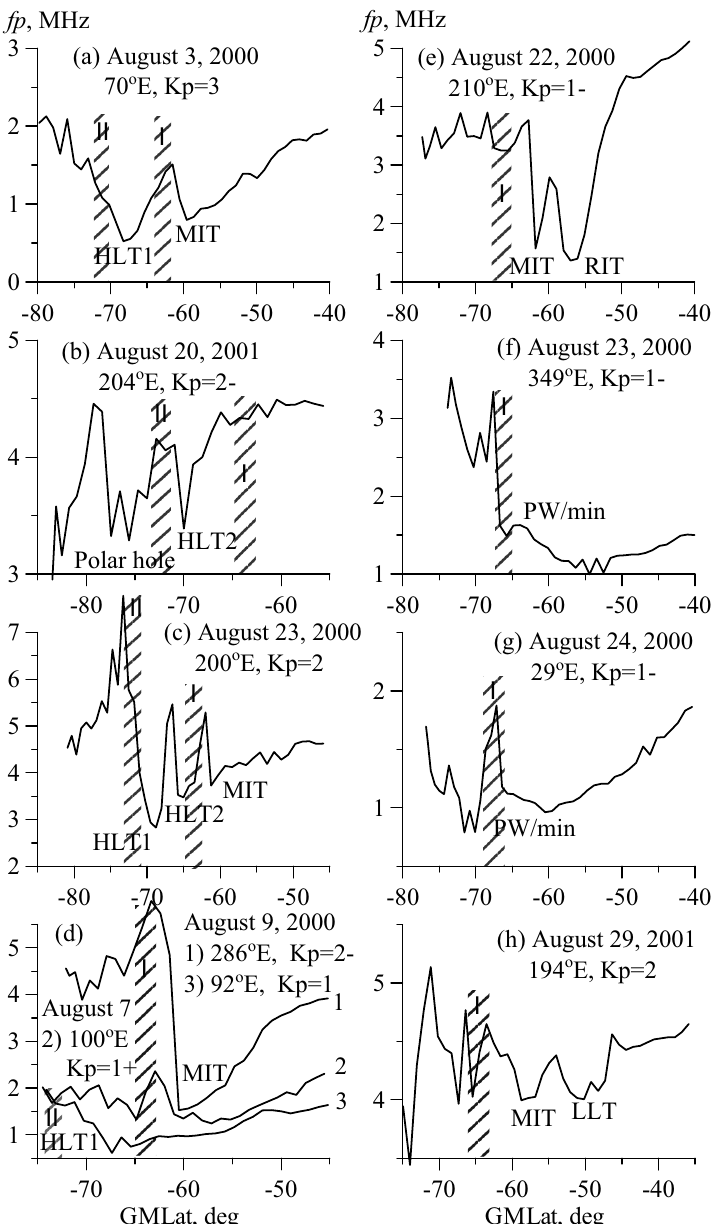
Figure 2. The most characteristic examples of troughs in the nighttime winter ionosphere of the southern hemisphere. Local time changes from 23.8 to 0.9 h. The hatching bars show the zones I and II of precipitation taking into account longitude and Kp index. Details are in the